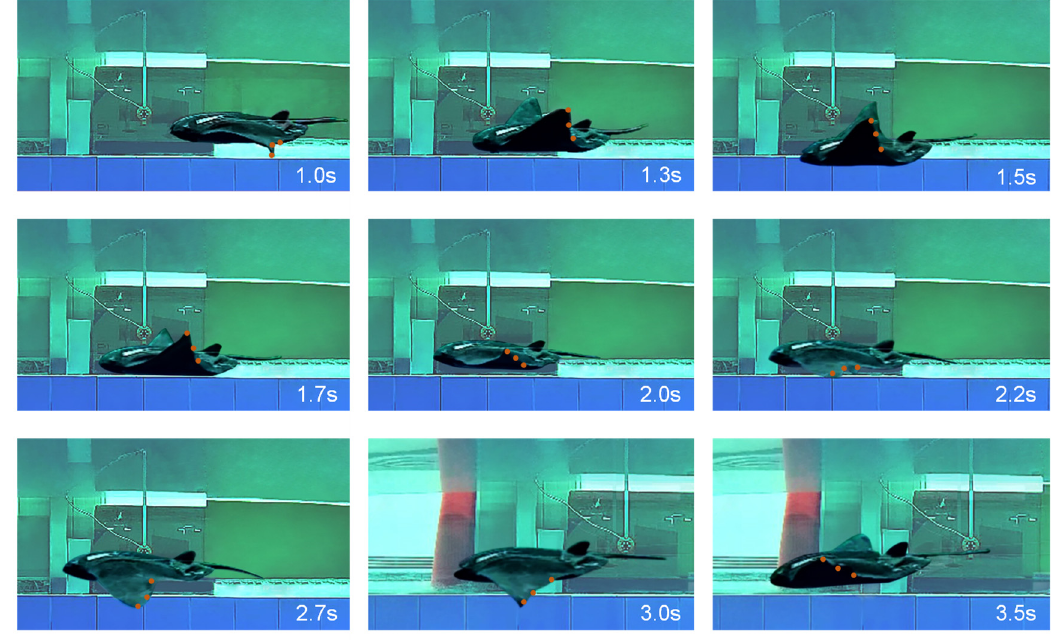
Figure 11. Experiment results of forward swimming motion sequence frame diagram (after optimization).